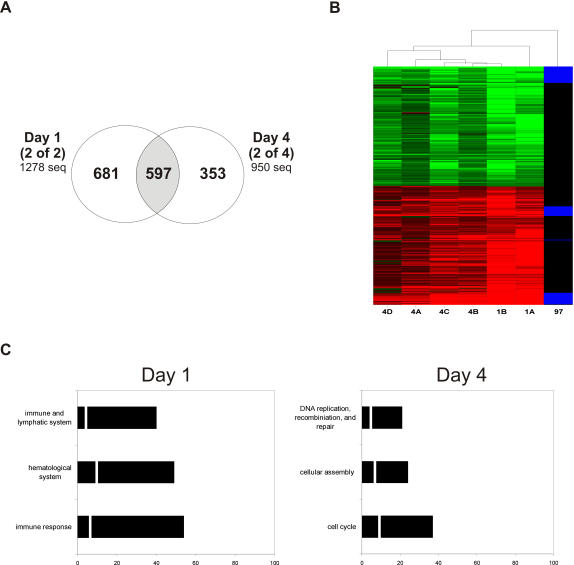
Common and Unique Temporal Gene Responses to SARS-CoV Infection(A) The Venn diagram shows genes with an absolute fold change > 2 and p < 0.0001 in two out of the two day 1 samples (left circle) or two out of the four day 4 samples (right circle).(B) The heat map includes the 597 genes from the grey Venn diagram intersections. The right column highlights the 97 genes that are commonly regulated in all six samples with blue. All 97 genes are listed in Figure S1. All gene expression profiles are the results of comparing gene expression in lungs of experimental animals versus gene expression in lungs of mock-infected animals (pooled).(C) Functional annotation was used to categorize the 681 unique genes at day 1, and the 353 unique genes at day 4. The percentage of genes within the top functional categories is indicated in the day 1 and the day 4 bar graph, with a white line indicating the percentage of genes found at the alternative day. Cell-to-cell signaling and cell death, other top categories on day 1, and cell death, cellular growth, and proliferation, additional top categories on day 4, are not included in the bar graph, as these categories were observed to have more genes differentially expressed in the common signature.